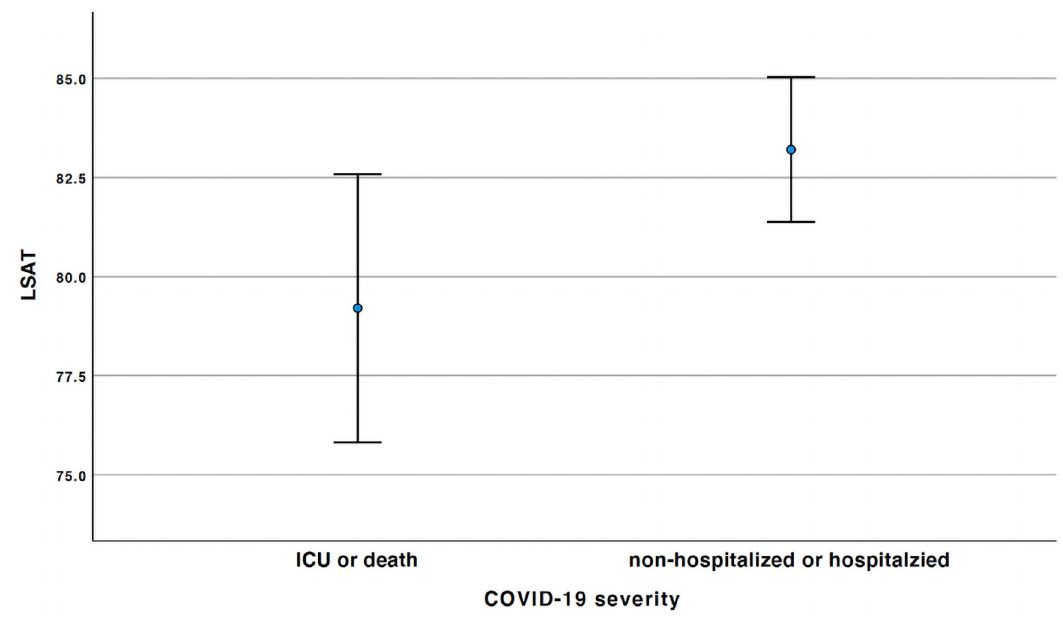
Fig 1. The means and 95% confidence intervals of the LSAT between the patients who were non-hospitalized or hospitalized and those who were admitted at ICU or death. Error bar graph, where the X-axis illustrates COVID-19 severity dichotomized as non-hospitalized or hospitalized and ICU or death. The Y-axis illustrates mean LSAT. COVID-19, Coronavirus disease 2019; ICU, intensive care unit; LSAT, low oxyhemoglobin desaturation.